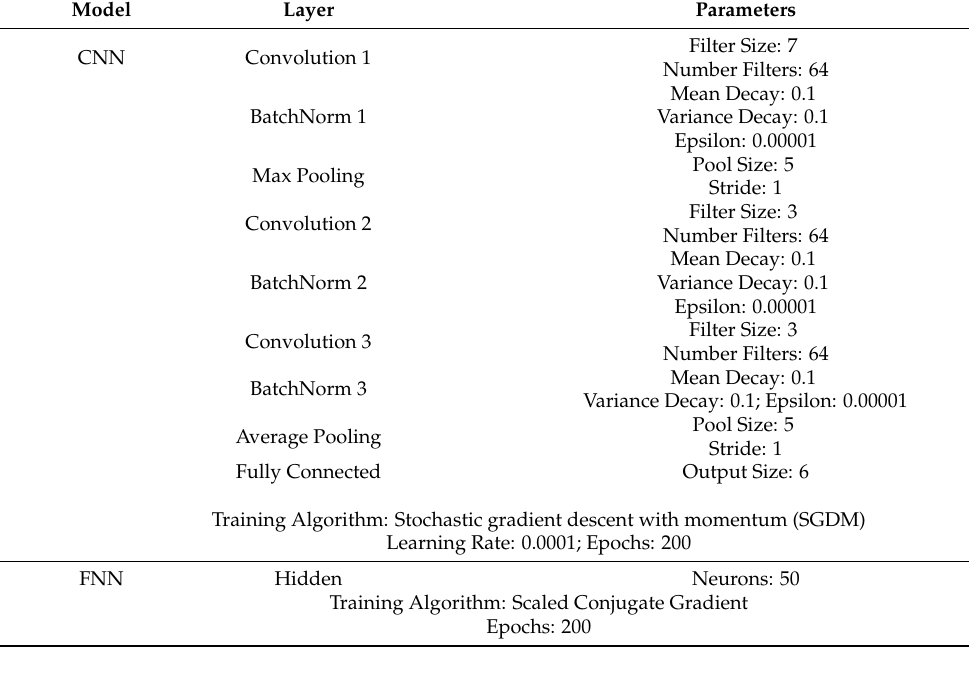
Table 3. Model training